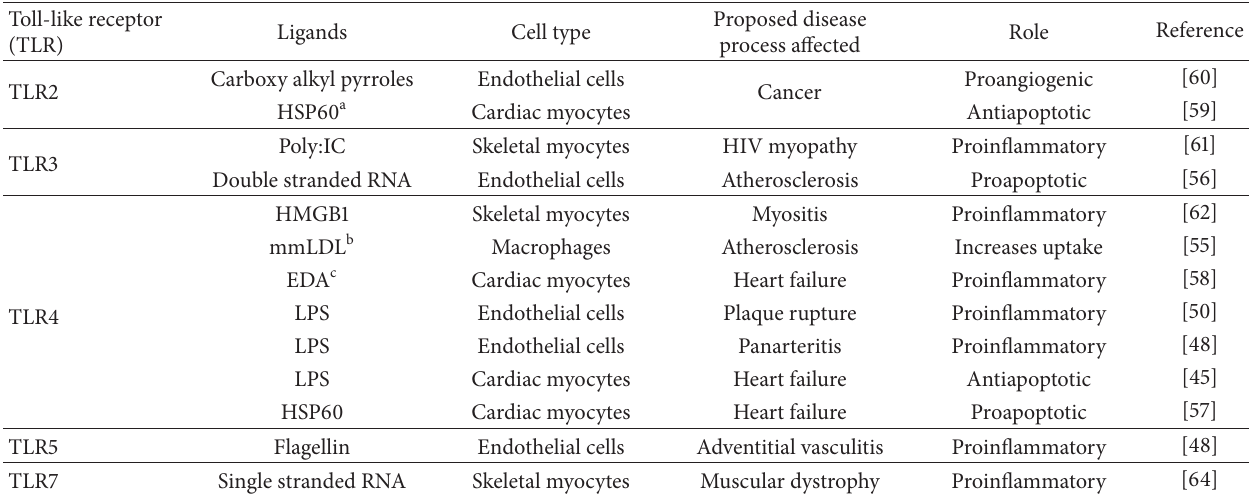
Table 1: Role of TLR in cardiovascular